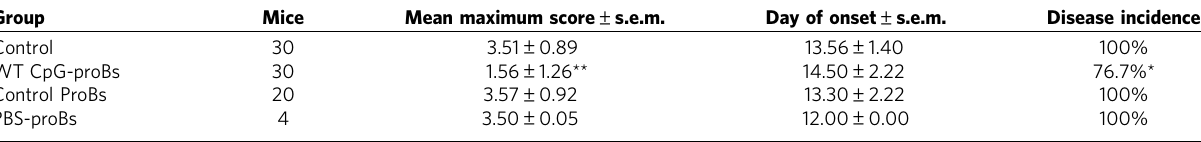
Clinical parameters from data in Fig. 1e, including the maximum clinical score (mean ± s.e.m.) of each treatment group and the day of disease onset (mean ± s.e.m.) among mice with EAE as well as the disease incidence over the entire observation period (35 days). Control mice received PBS injection instead of progenitor injection. Significant differences between CpG-proB recipients versus control mice are indicated; * P o 0.05, ** P o 0.005, assessed by non-parametric Mann–Whitney’s t -test.